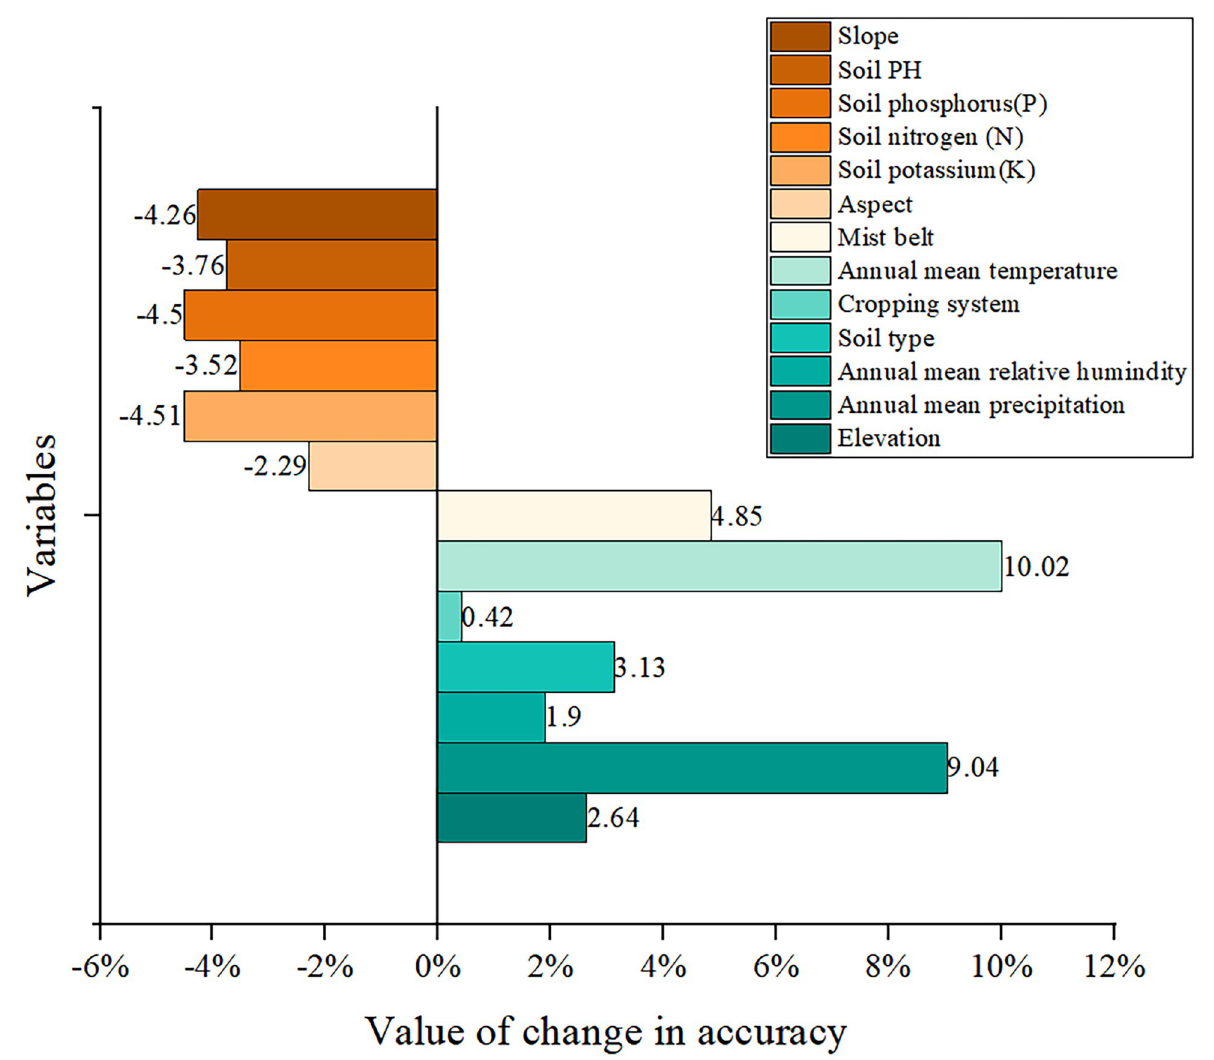
Fig 18. Comparison of the importance of variables in the FA+ResNet